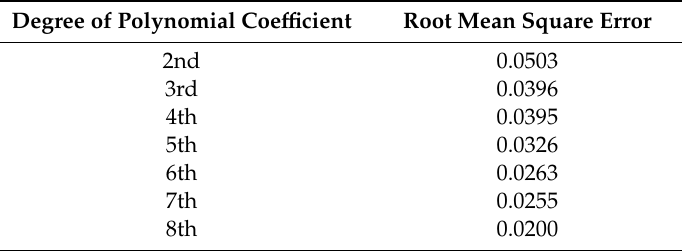
Figure 8. Residuals along the time as a function of the numbers of coefficient in the regression of a flat-bottomed hole of size 16 mm and depth 2 mm [Frequency = 50 Hz, number of frames = 250, truncation window = 5 s]. Table 1. Root mean square error as a function of the numbers of coefficient in the regression for a flat ‐ bottomed hole of size 16 mm and depth 2 mm.